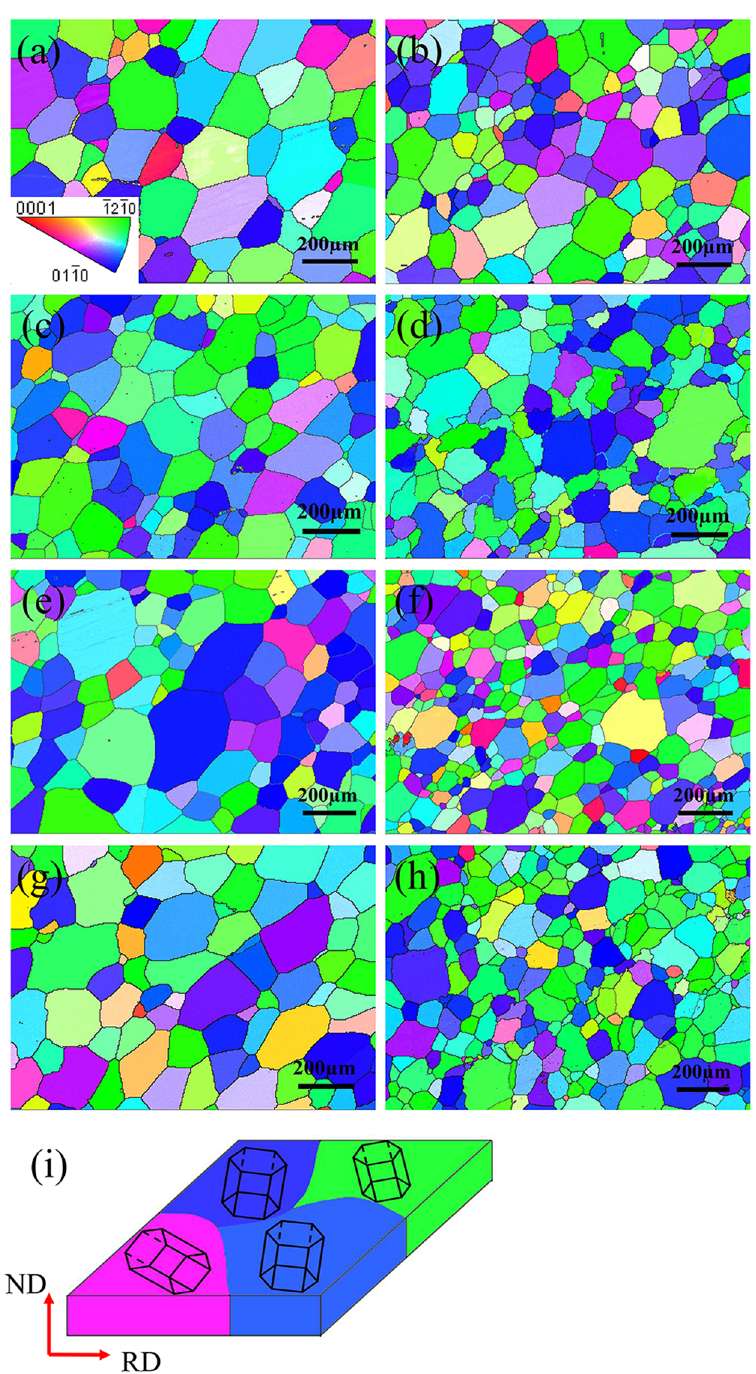
Figure 8. IPF images of the studied alloys: ( a ) Mg-3Zn 20% rolled and ( b ) 50% rolled aged for 25 h; ( c ) Mg-5Zn 20% rolled and ( d ) 50% rolled aged for 25 h; ( e ) Mg-3Sn 20% rolled and ( f ) 50% rolled aged for 35 h; ( g ) Mg-5Sn 20% rolled and ( h ) 50% rolled aged for 35 h; and ( i ) schematic of the grain orientation and microstructure of the